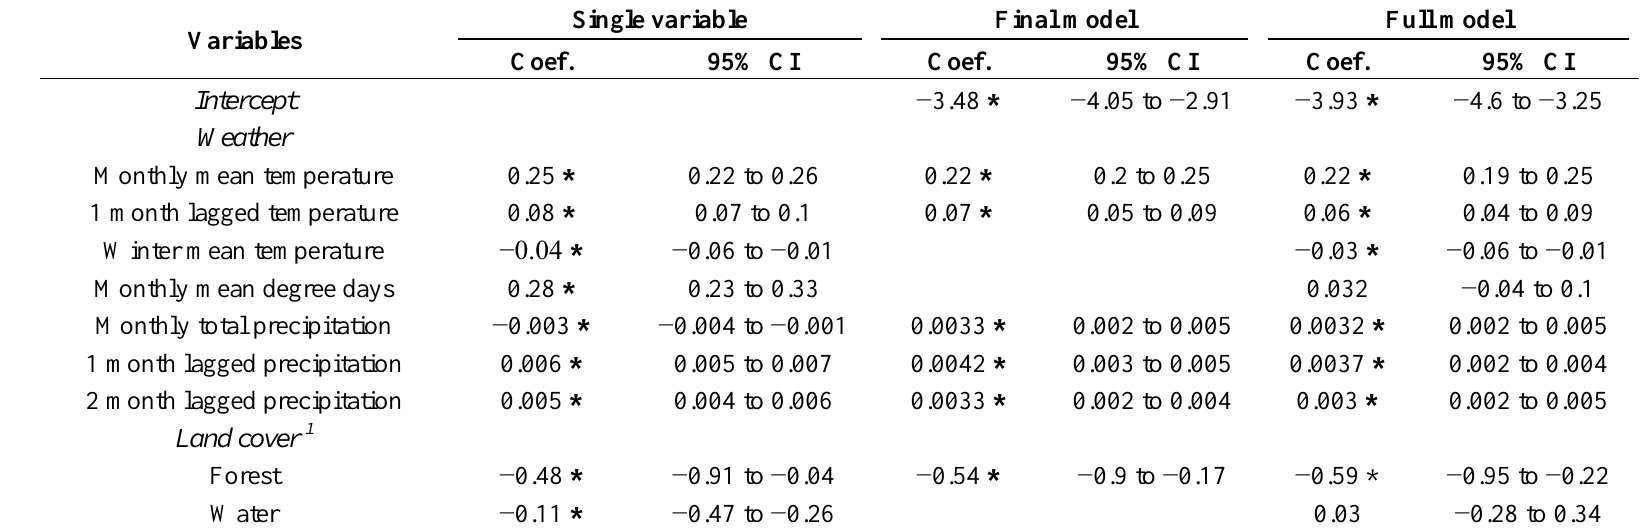
Table 2. Estimated coefficients of explanatory variables in the constructed models of Cx. tarsalis abundance. Single variable indicates the explanatory variables which are assessed individually. Final model represents the final fitted model with the lowest AICc value. Full model is model fitted with all created explanatory